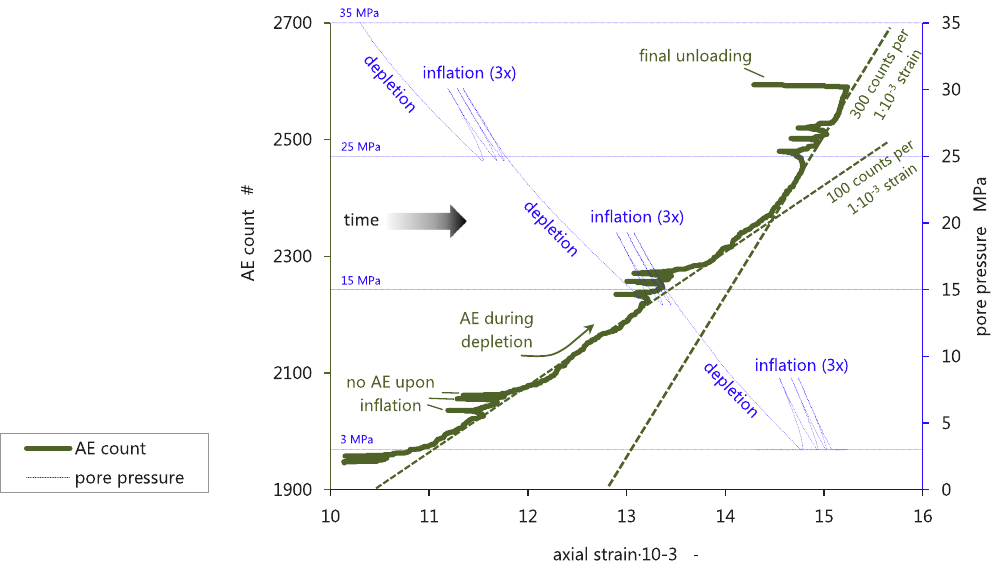
Figure 6. Acoustic Emission (AE) count (left axis) and pore pressure (right axis) versus axial strain for the full depletion trajectory within a UPPD/M protocol. Sample tested is ZRP-3A_123DV. Note, that no AE activity can be seen during inflation-deflation steps, and that a clear kink in the global AE count versus strain trend can be observed around 14.5∙10 − 3 axial